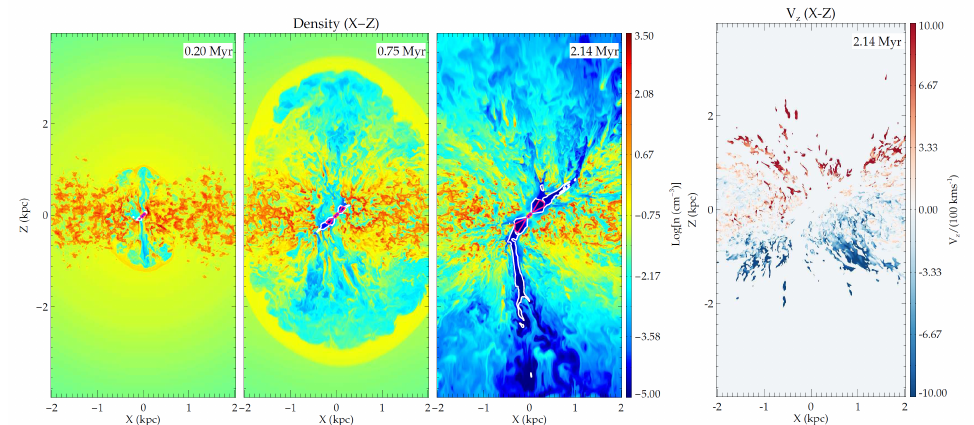
Figure 7. One of the simulated interactions between the jet and the gas by Mukherjee et al. [85], in this case with in 45 ◦ inclination between the jet axis and the galaxy disk plane. Left panels display the time evolution of the gas density along the radio axis plane. The right panel shows the projected velocity of the gas, where a clear enhanced component is observed perpendicularly to the jet. As a result of the enhanced interaction with the ISM, in comparison to scenario with the jets being launch perpendicularly to the disk, the jet is decelerated and generate higher turbulence dispersion, mainly towards the path of less resistance perpendicularly to